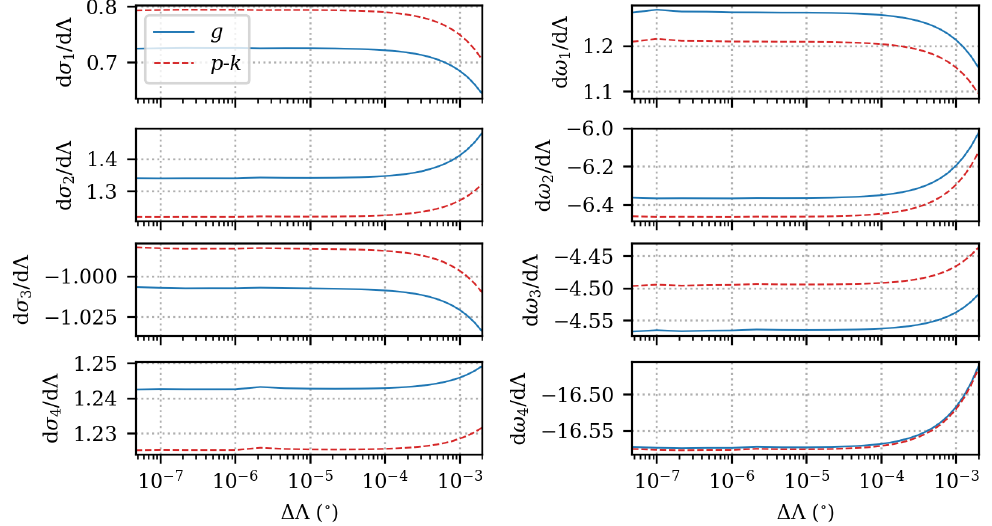
Figure 8. Convergence of the eigenvalue sensitivities for the AGARD 445.6 weakened model employing the p - k method and the g method at V = 193.9 m/s over the step size ∆Λ for the model